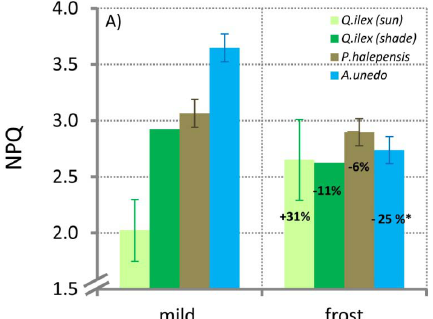
2 3 Figure 8. Bar plot of the effect of a sudden period of frost follow- ing a mild winter period on non-photochemical quenching (NPQ) in sunlit leaves of Q. ilex (light green bar), in shaded leaves of Q. ilex (dark green bar), P. halepensis (beige bar) and A. unedo (blue bar). The error bars represent the standard error, and the percentages in- dicate the change between periods where significance is indicated with an asterisk ( P ≤ 0 .